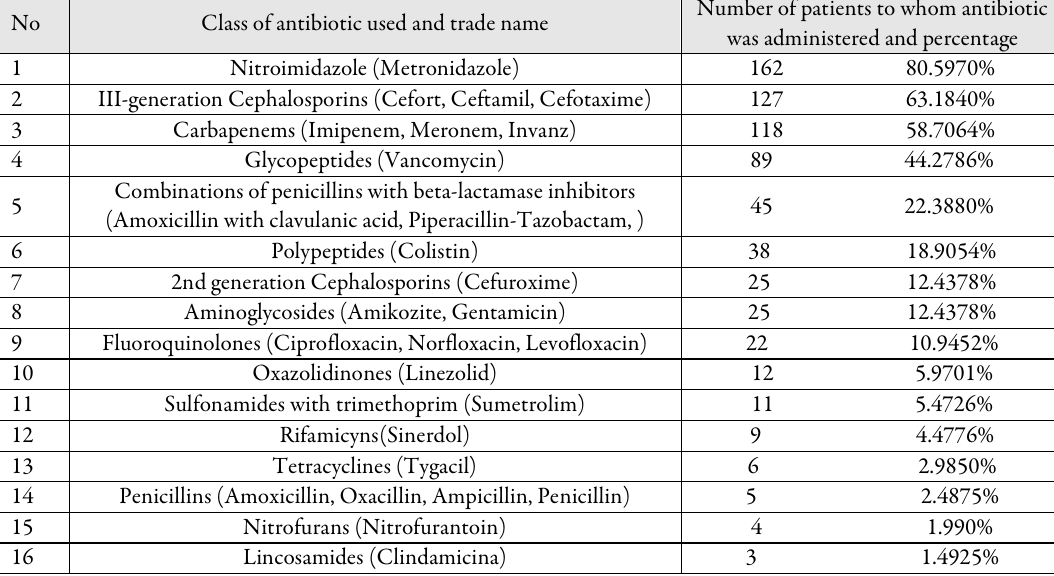
Table 5. Classes of antibiotics administered to patients included in the